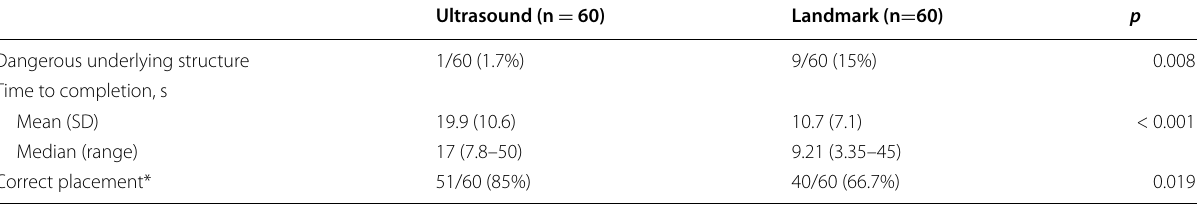
Table 2 Outcome measurements by the use of ultrasound as compared to the landmark technique